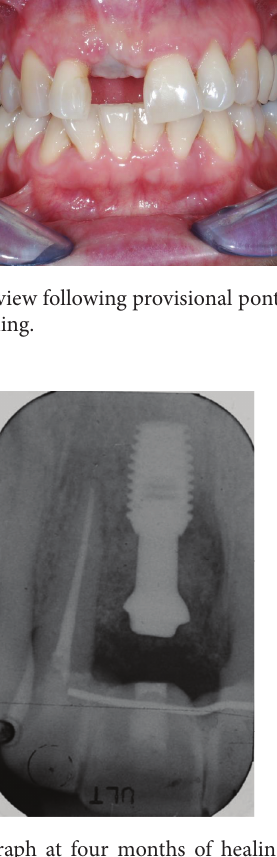
Figure 18: Radiograph at four months of healing showing good integration of the implant and the grafted material.